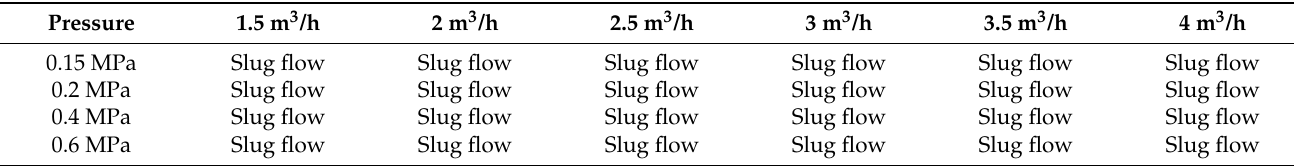
Table 2. Flow patterns of different pipe pressures inclined up to 10 ◦ .